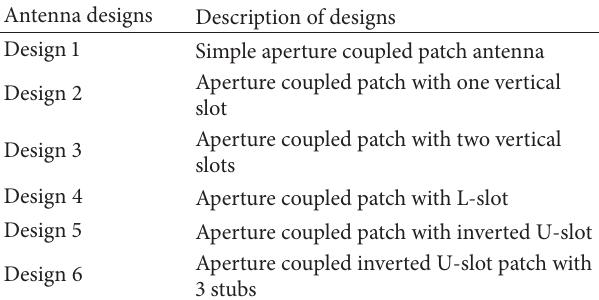
Figure 6: Gain versus frequency plot of calculated and measured results of proposed antenna. Table 2: Description of antenna designs mentioned in Table